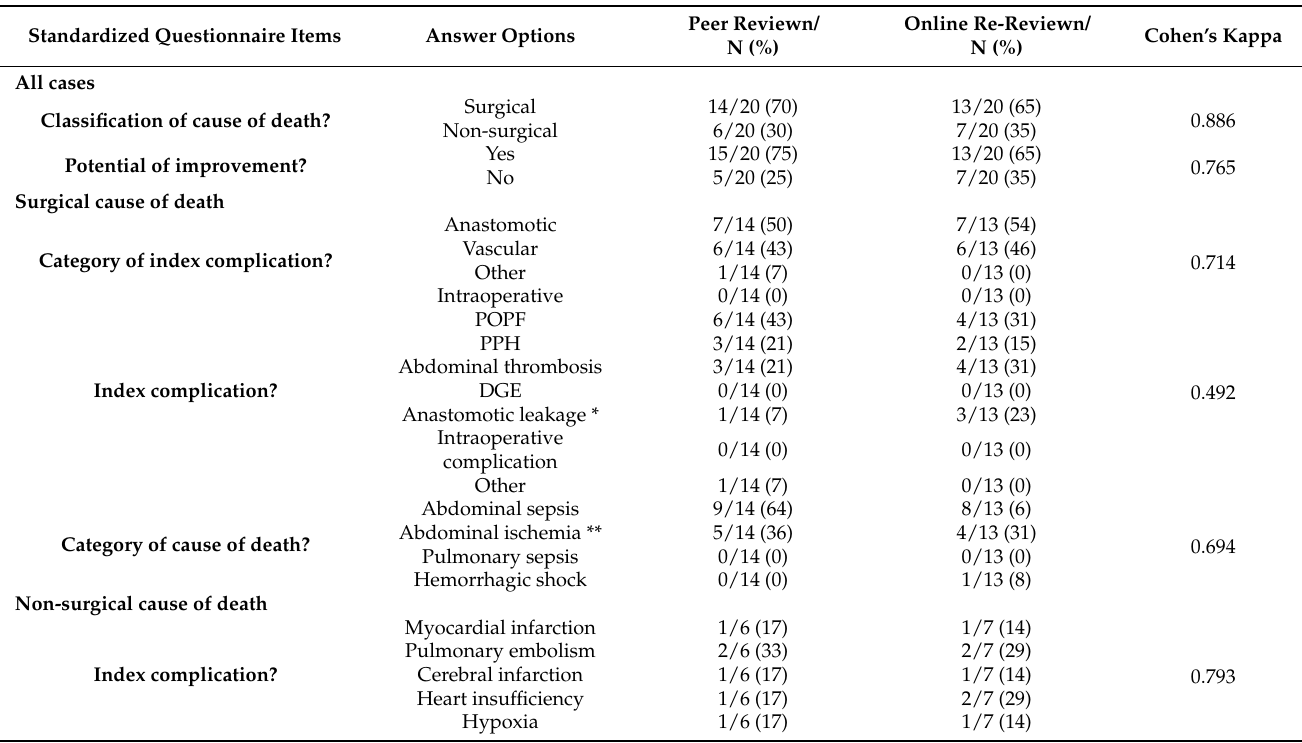
Table 6. Test-retest reliability of the standardized review questionnaire.